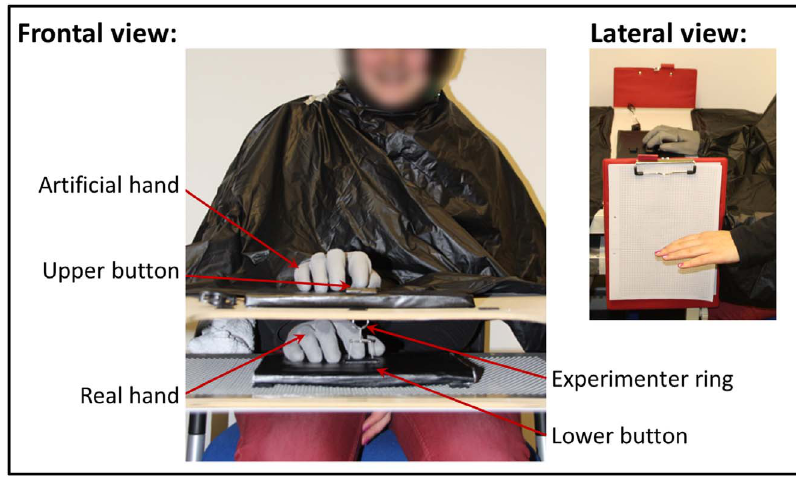
Figure 1. Experimental design, frontal view. Participants placed their right hand on the lower plate, whereas the artificial hand was placed directly above on the upper plate. The artificial hand’s index finger and the lower button were connected via a string. Hence, whenever either the lower button was pressed by the participant (self-agency) or the ring was moved up or down by the experimenter (other-agency), the index finger of the artificial hand moved up or down accordingly. Lateral view. Illustrated is the measurement of the proprioceptive drift. Participants closed their eyes, stretched out their left arm and indicated with their left index finger the perceived height of their right hand. The height of the participant’s left index finger was then marked by the experimenter onto the scale paper attached to each side of the